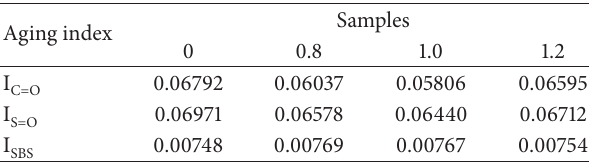
Table 4: I , I , and I changes of SBS-modified asphalt mortar C=O S=O SBS after UV